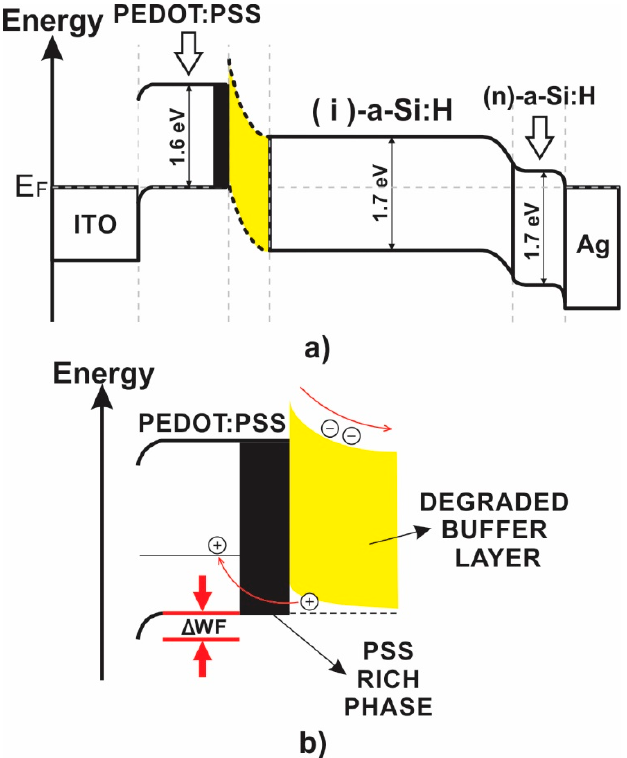
Figure 4. ( a ) Energy level band diagram in thermal equilibrium for a hybrid structure and ( b ) schematic representation of the electron-blocking mechanism with the buffer layer (SIC:H/Si:H) by interfacial wide energy gap PSS [26].